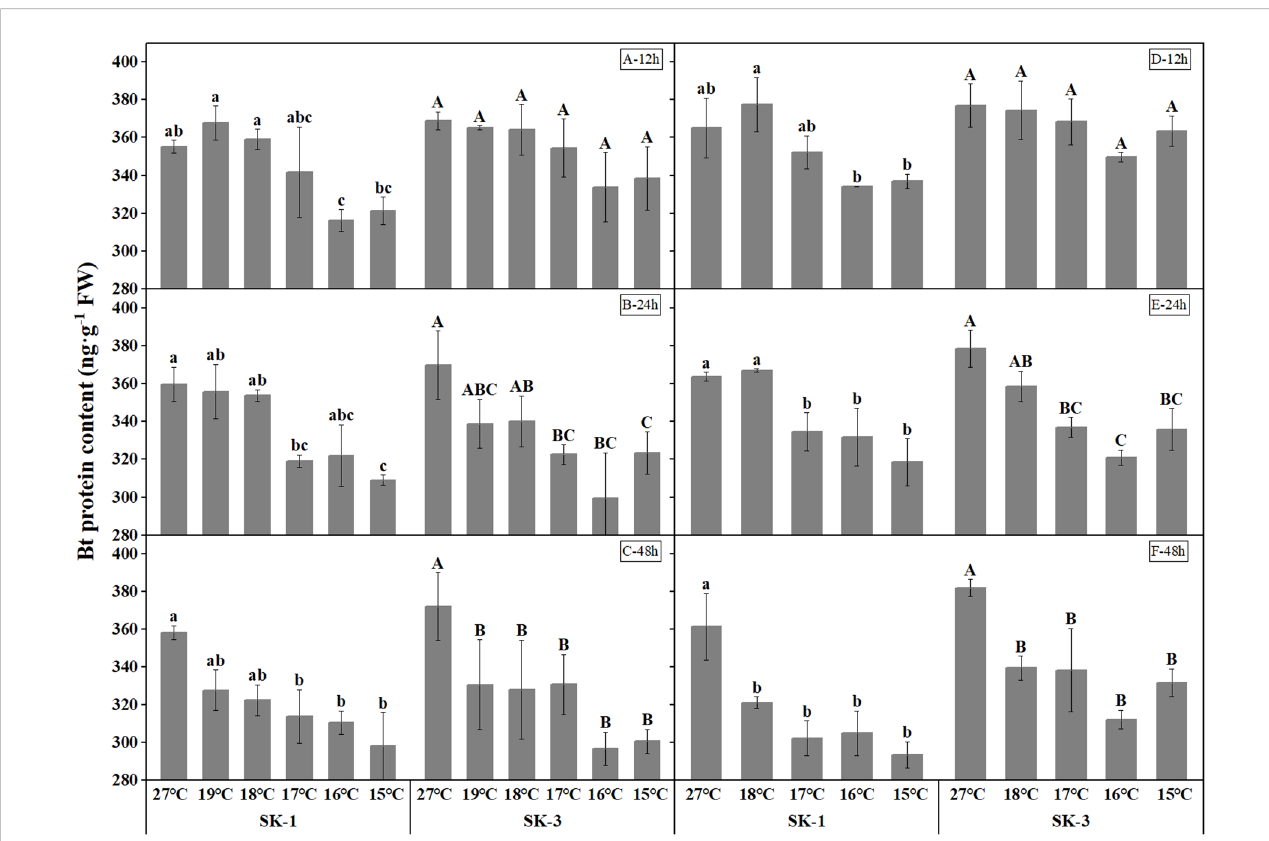
FIGURE 2 Effect of low temperature stress on Bt insecticidal protein content in cotton leaves in 2020 ( A-C : 12h, 24h, 48h stress) and 2021 ( D-F : 12h, 24h, 48h stress). FW represents fresh weight.Different lowercase letters indicate the signi fi cant differences between the treatments of the variety SK1, and different capital letters indicate the signi fi cant differences between the treatments of the variety SK3